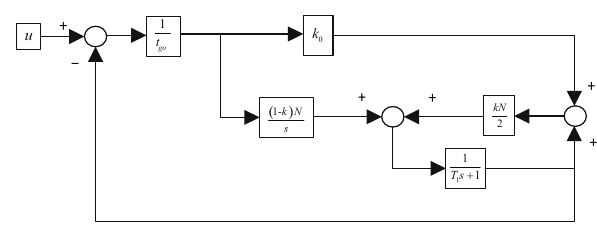
Figure 3: Equivalent fi rst - order linearized AACG guidance system